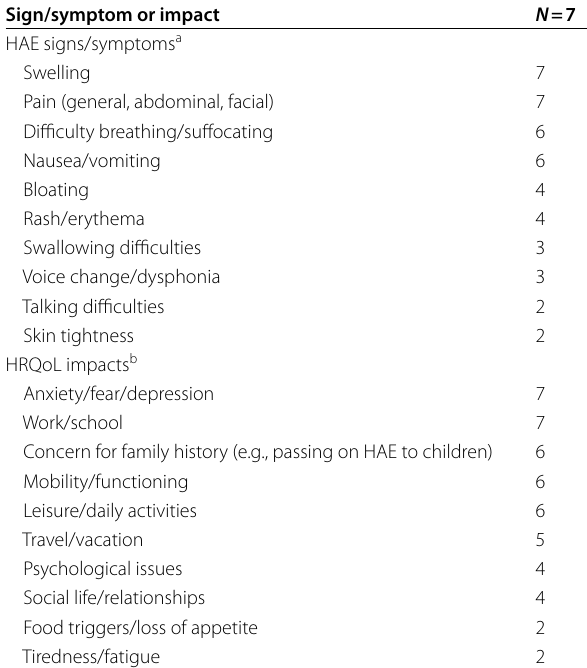
Table 1 Signs/symptoms and HRQoL impacts on patients, as reported by clinical